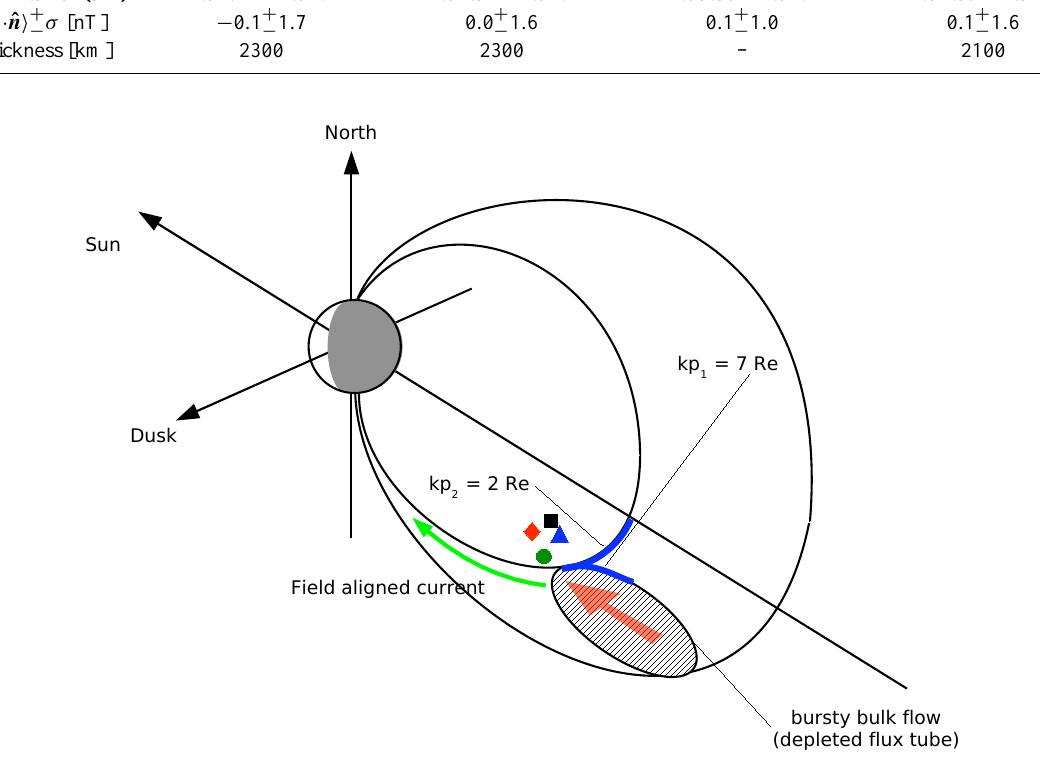
Fig. 5. A schematic overview of the orientation of the BBF. The Cluster quartet, located below the neutral sheet, encounters the dawn flank of the BBF, and observes a downward (into the ionosphere) field aligned current. The magnitude of the local curvatures kp1 and kp2 (indicated by the blue curve segments), of the structure is estimated to be 7 and 2 R E , respectively. Adapted from Birn et al. (2004).